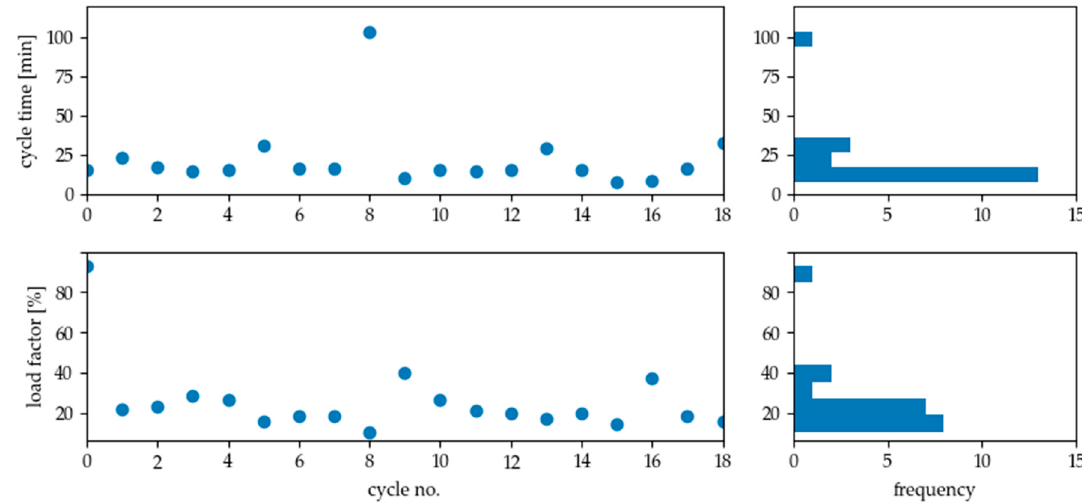
Figure 17. Result of load analysis for cleaning machine during production (8 a.m to 4 p.m). The resulting average cycle time is 21.63 min, the mean load factor of all full cycles is 25.8%.